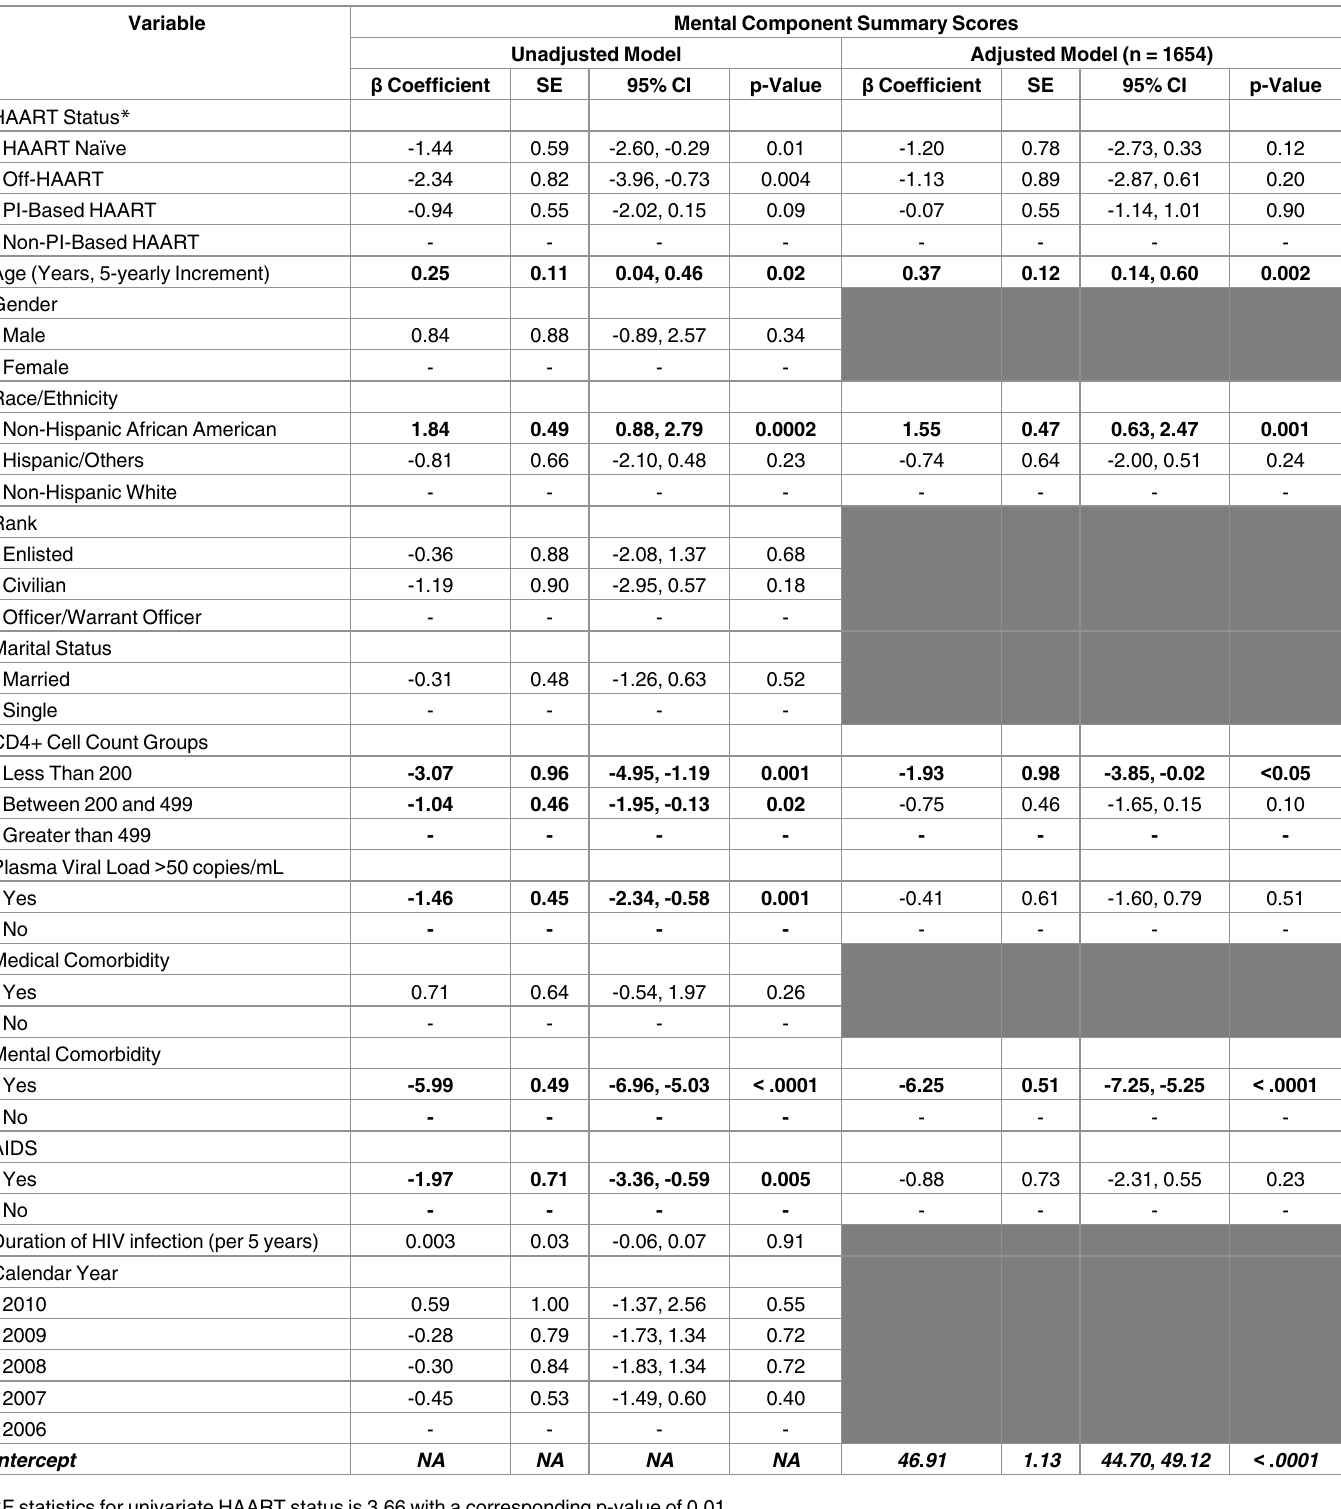
Table 5. Factors Associated with mental component summaryscores at